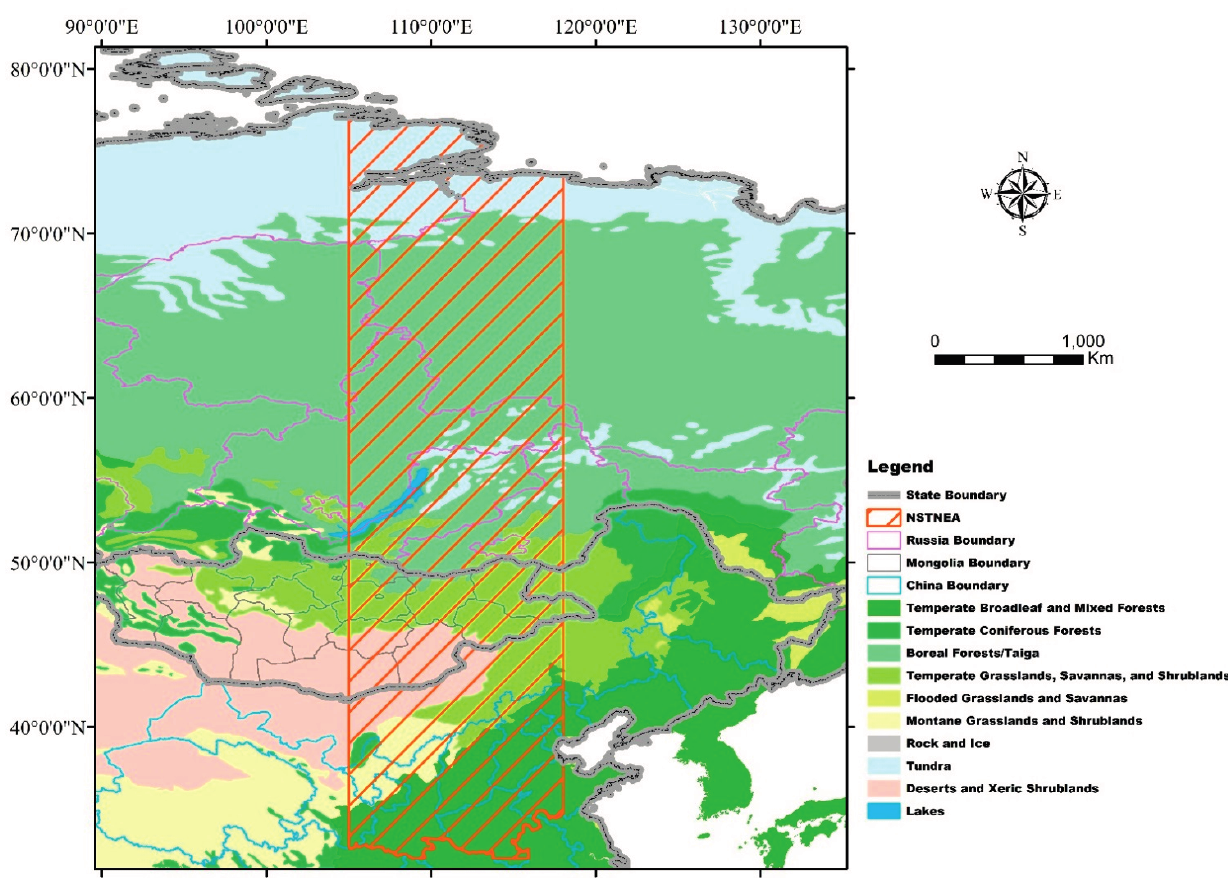
Figure 1. Location of the study